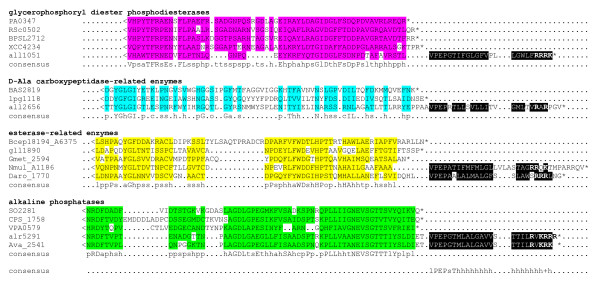
Sequence alignments of the C-terminal ends of enzyme families in which at least one member has an appended PEP-CTERM domain. (In the consensus sequences: a = aromatic, c = charged, h = hydrophobic, l = aliphatic, o = hydroxyl, p = polar, s = small, t = tiny, + = positive).